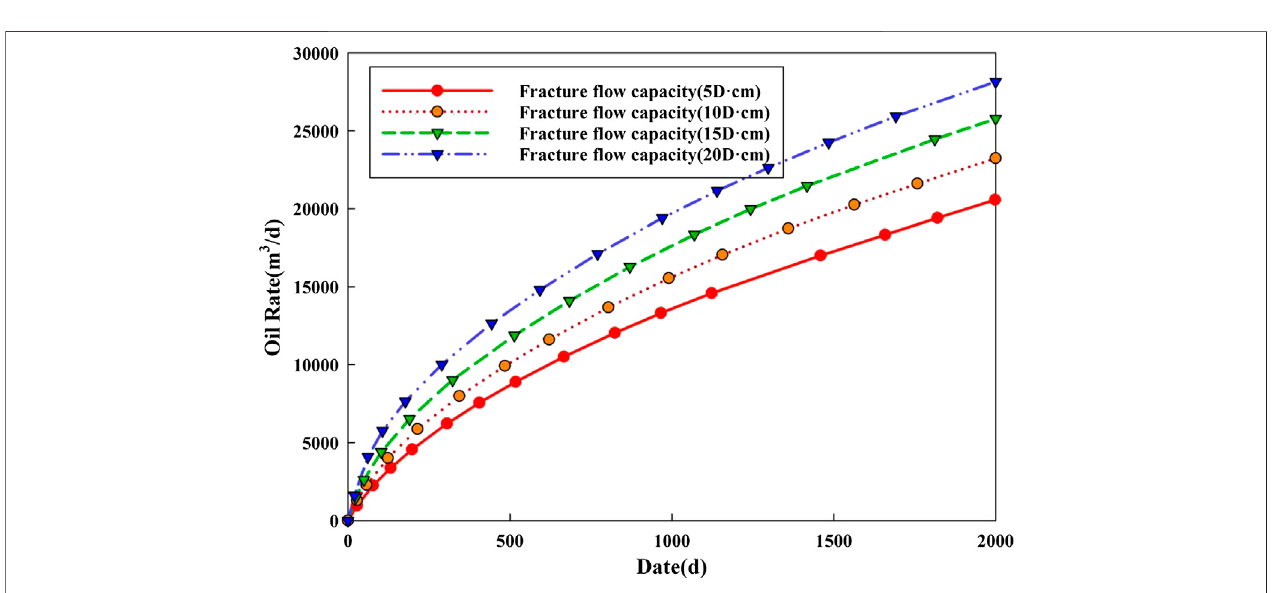
FIGURE 16 | Cumulative oil production curve of different fracture fl ow